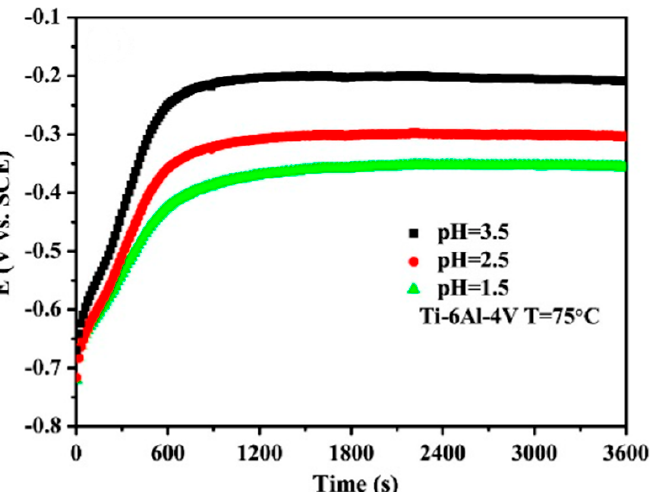
Figure 11. Influence of electrolyte pH (0.05 M SO 42 − with 2 ppm HF) on open-circuit potential of Ti-Al6-V4. Reprinted from [31] copyright (2016), with permission from Elsevier.